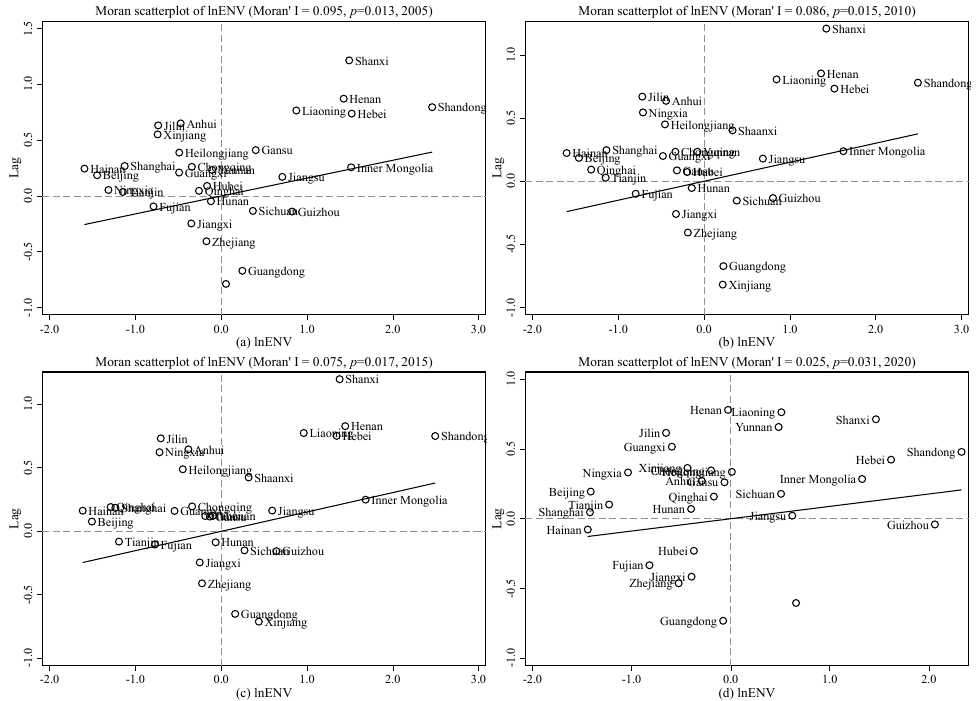
Figure 2. Dynamic changes about spatial autocorrelation (Moran’s I) of environmental pollution. Notes: ( a – d ) the dynamic changes about spatial autocorrelation of environmental pollution in 2005, 2010, 2015 ,and 2020, respectively. The Moran scatter chart is divided into four quadrants: The first quadrant indicates that provinces with higher environmental pollution are surrounded by provinces with higher pollution; the second quadrant indicates that provinces with lower environmental pollution are surrounded by provinces with higher pollution. The third quadrant indi- cates that provinces with lower environmental pollution are surrounded by provinces with lower pollution. The fourth quadrant indicates that provinces with higher environ- mental pollution are surrounded by provinces with lower pollution. The Moran index values are 0.095, 0.086, 0.075, and 0.025 in Figure 2, respectively, indicating that environ- mental pollution has significant positive spatial agglomeration characteristics; that is, high-polluted areas are surrounded by high-polluted areas, and low-polluted areas are surrounded by low-polluted areas. In order to show the environmental pollution status of each province more intuitively, Figure 3 shows the provinces corresponding to each of the four scatter diagrams above.